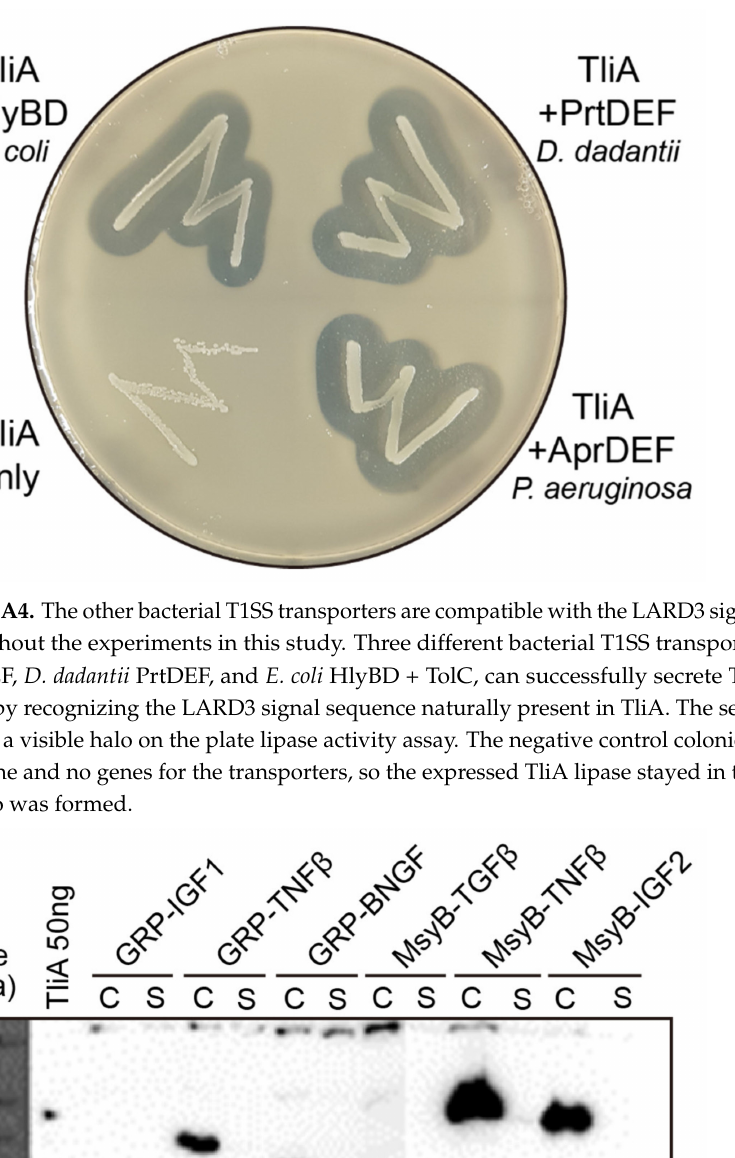
LCD graphs of glutathione S-transferase (GST) and streptavidin (SAv), and their negatively super- charged variants, GST( − 20) and SAv( − 10). The secretion tests of these proteins are presented in Figure 4a. ( e – g ) The LCD graphs of cutinase (Cuti), MelC2 tyrosinase, and M37 lipase, and their negatively supercharged variants Cuti( − ), MelC2( − ), and M37( − ). The secretion tests of these pro- teins are presented in Figure 4c. ( h ) The LCD graphs of M37 lipase and its variant obtained from a mutation and screening approach, M37(var). The secretion tests of these proteins are presented in Figure 6a.